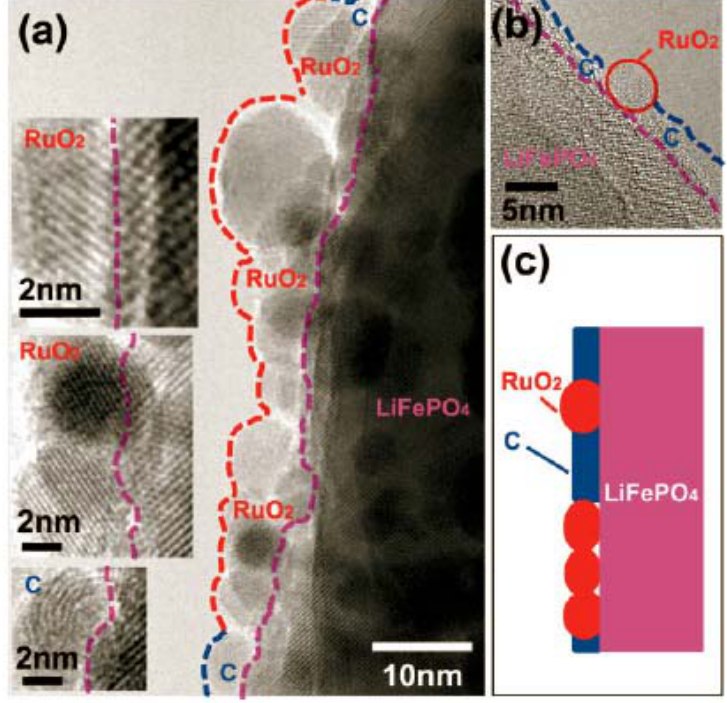
Figure 4. (a and b) High resolution TEM images of C-LiFePO Schematic of the repair of the electronically conducting network of carbon on